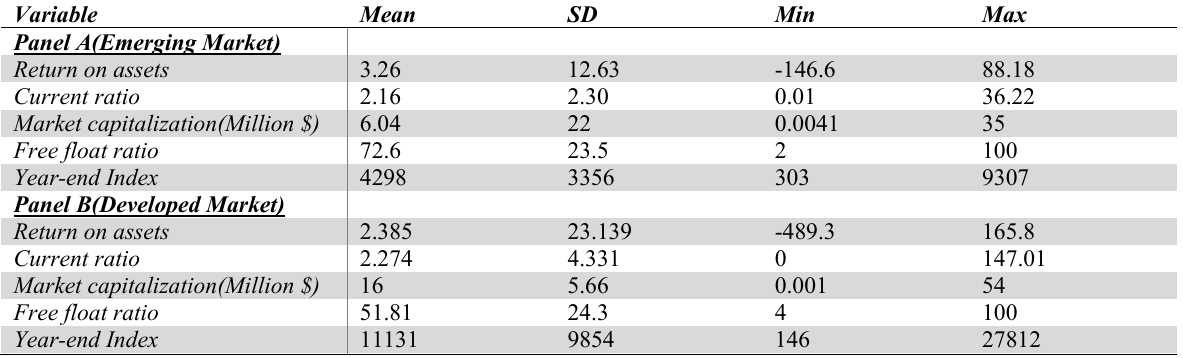
Summary Statistics of